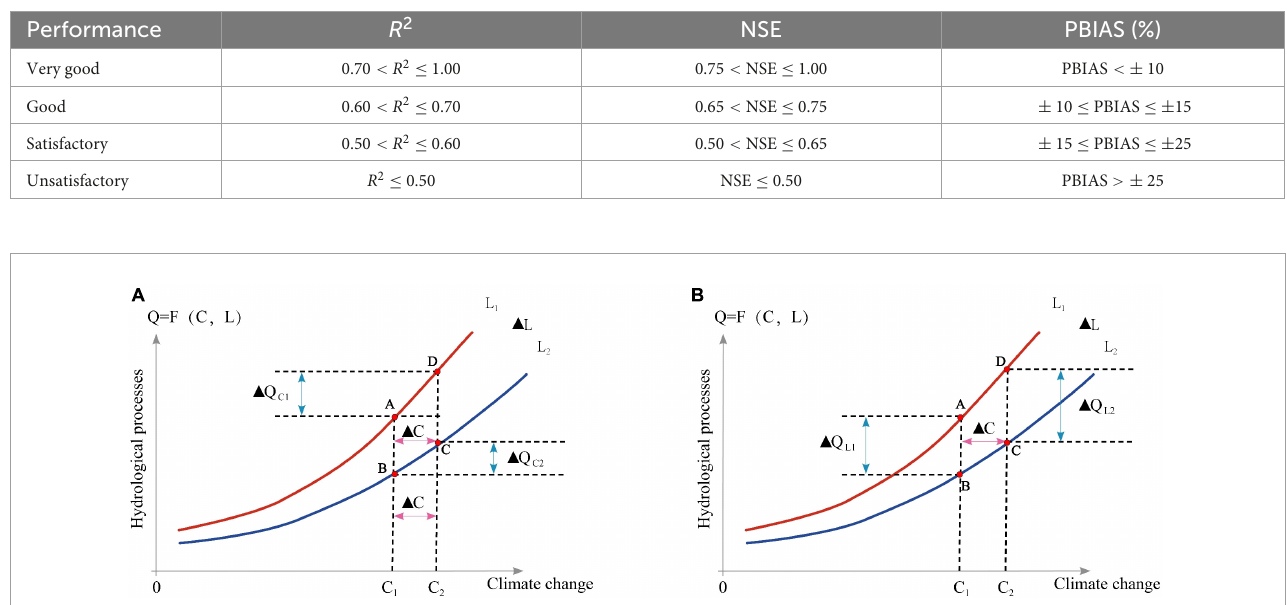
FIGURE2 A diagram showing how climate change (A) and changes in how land is used (B) affect hydrological processes. C 1 and C 2 represent different climatic conditions, L 1 and L 2 represent different land use types. A, B, C, D represent the values of hydrological components (water yield, evapotranspiration, etc.) under the conditions of Q L 1 C 1 , Q L 2 C 1 , Q L 2 C 2 , Q L 1 C 2